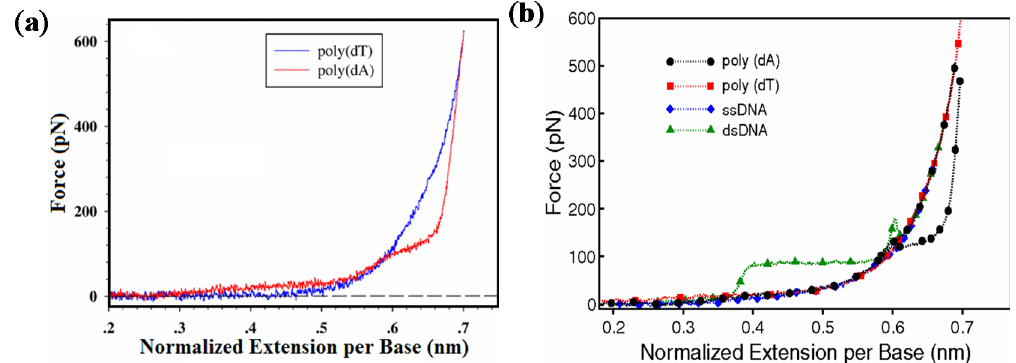
Figure 4. Force-extension curves for ssDNA. ( a ) Comparison of pulling curves between poly(dT) and poly(dA). Reprinted with permission from [60]. Copyright (2007) by the American Physical Society; ( b ) Force-extension curves for different forms of dsDNA and ssDNA. Reprinted with permission from [3]. Copyright (2010) by the American Physical